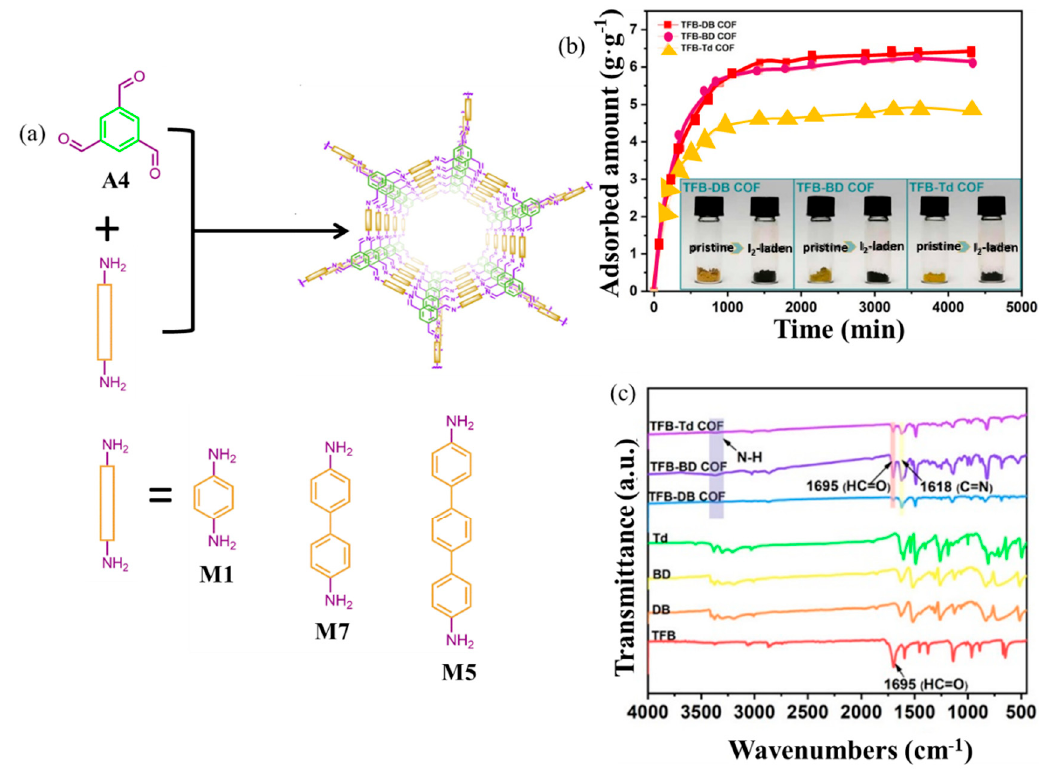
Figure 4. ( a ) Synthesis of TFB-DB, TFB-BD, and TFB-Td COFs. ( b ) IR spectra of the TFB, DB, BD, Td, and TFB-DB COFs, the TFB—BD COF, and the TFB-Td COF. ( c ) Adsorption curves of the investigated COFs. Reprinted/adapted with permission from Ref. [59]. Copyright (2021), American Chemical Society.